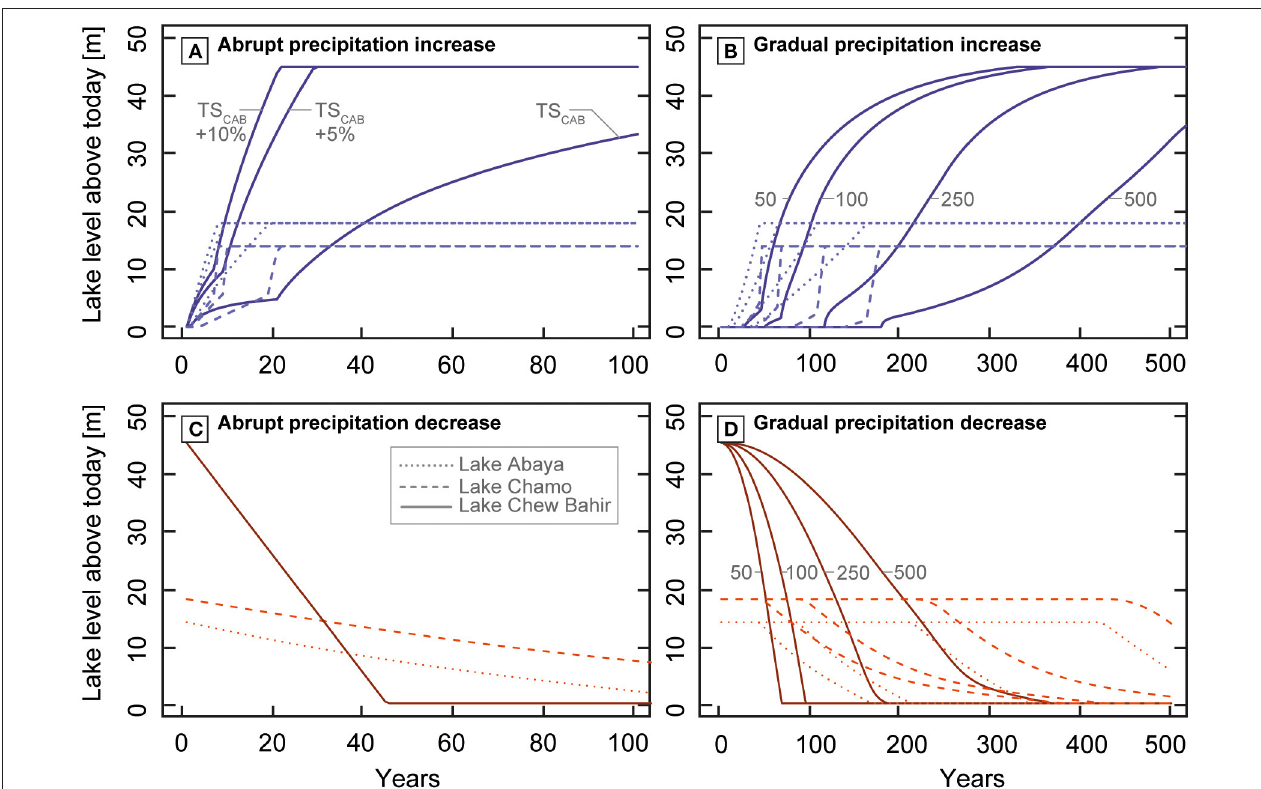
FIGURE 6 | Modeled pace of lake transitions under abrupt and gradual precipitation changes: (A) Abrupt increase in precipitation from modern values to TS CAB values (13.4%) as a minimum possible amount of rainfall to fill up the investigated lake basins. TS CAB + 5% and TS CAB + 10% are provided as examples for even higher precipitation that was provided during the AHP, for example. (B) Lake fill scenario under gradual increase in precipitation from modern values to TS CAB values over 50, 100, 250, and 500 years. (C) Abrupt decrease in precipitation from TS CAB to modern values. (D) Lake regression scenario under gradual decrease in precipitation from TS CAB to modern values over 50, 100, 250, and 500